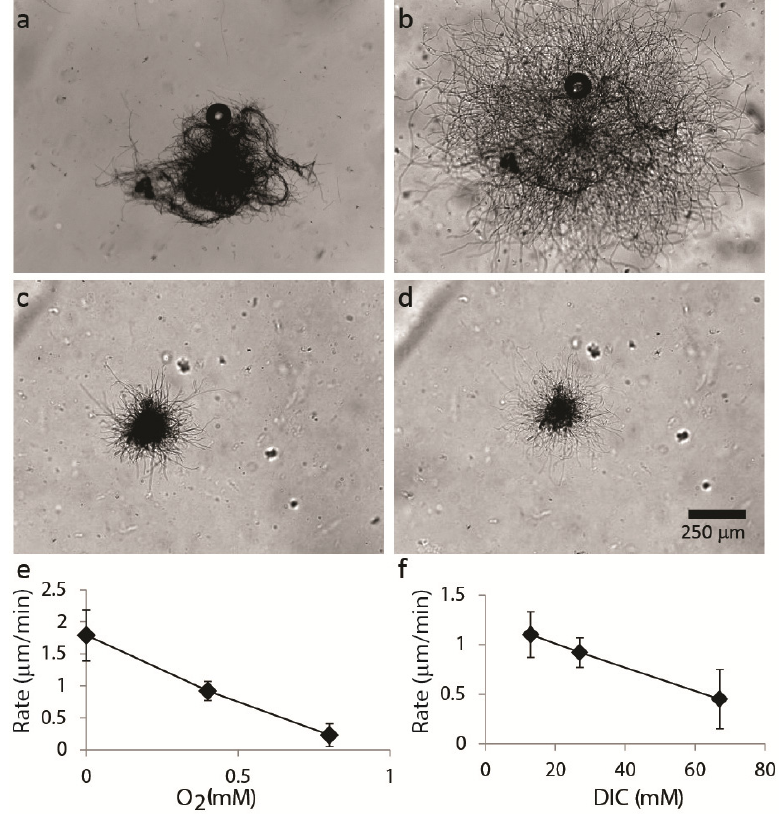
Figure 5. Migration of filaments away from clumps as a function of O inorganic carbon (DIC) in the solution. All photomicrographs are shown on the same scale. ( a ) Three-dimensional clump containing bent filaments before incubation in 0 mM O 27 mM DIC; (b ) The same clump after the 2-h incubation in 0 mM O Note that many filaments became horizontal and glided away from the clump; ( c ) Photomicrograph of a clump before incubation in 0.8 mM O same clump after the 2-h incubation in 0.8 mM O migration rates of filaments away from clumps as a function of O solution; ( f ) Horizontal migration rates away from clumps as a function of DIC concentration in the